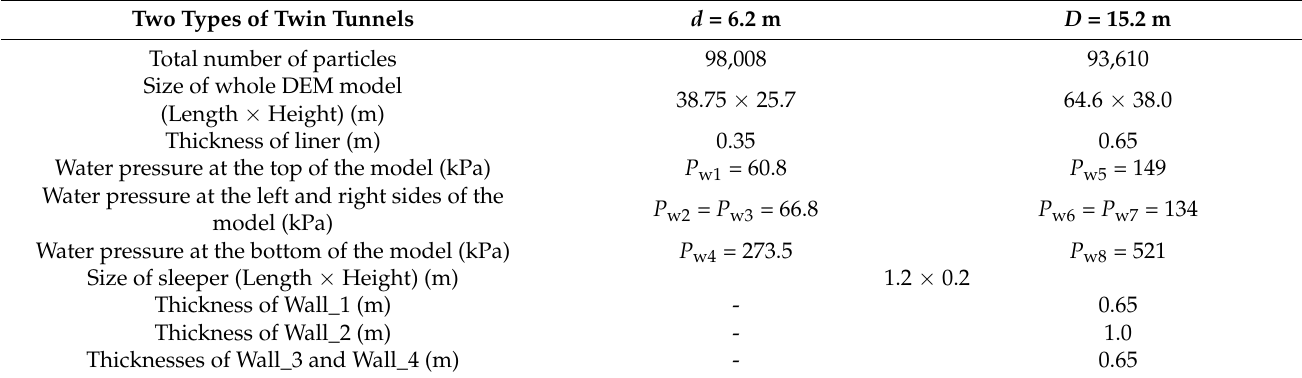
Table 4. Parameters of small ( d ) and super-large ( D ) twin tunnels in the DEM model.